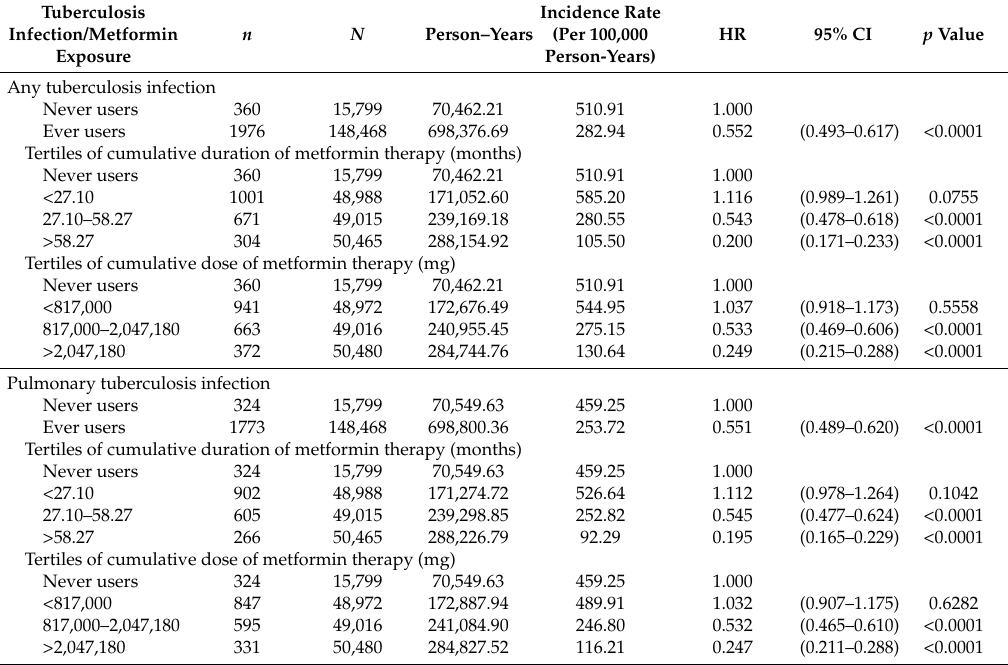
Table 2. Incidence rates of tuberculosis infection and hazard ratios by metformin exposure.